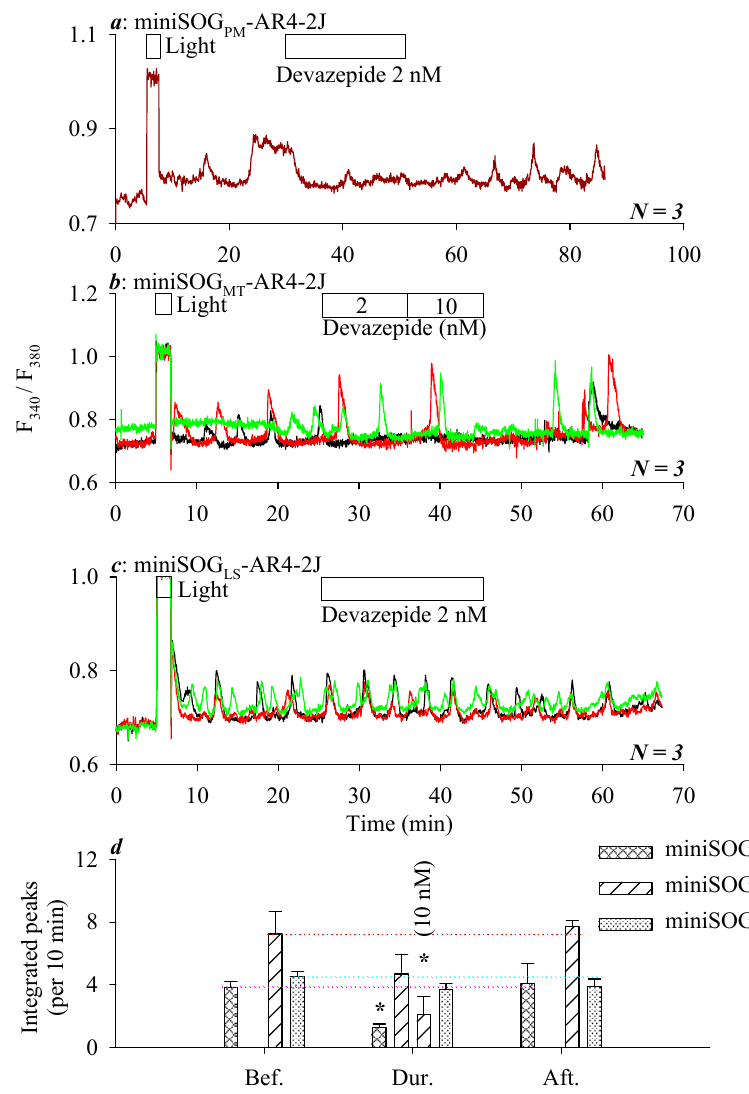
Figure 4. Calcium oscillations induced by miniSOG photodynamic action at the plasma membrane (PM), mitochondria (MT), or lysosomes (LS) in AR4-2J cells showed graded sensitivity to inhibition by the CCK1R antagonist devazepide at 2 nM: PM > MT > LS. Fura-2 AM-loaded miniSOG PM -AR4-2J ( a ), miniSOG MT -AR4-2J ( b ), or miniSOG LS -AR4-2J cells ( c ) were perfused; devazepide (2, 10 nM) and LED light (450 nm, 85 mW·cm − 2 , 1.5 min) were applied as indicated by the horizontal bars. The calcium tracings are each from individual cells measured simultaneously in one out of N (as indicated) identical experiments, the ordinate being fluorescence ratios in F 340 / F 380 and the abscissa being time in min, as indicated. Integrated calcium peaks (per 10 min) from N experiments were plotted, and statistically significant differences between before (Bef.) and during (Dur.) or after (Aft.) devazepide application were indicated by an asterisk (*) at p < 0.05 ( d ), for the devazepide inhibition of miniSOG photodynamically induced calcium oscillations with miniSOG PM or miniSOG LS . Note the thin pink (PM), cyan (MT), and red (LS) dotted horizontal lines (3) at the level before the devazepide application in miniSOG PM -AR4-2J, miniSOG MT -AR4-2J, and miniSOG LS -AR4-2J cells, respectively ( d ). In miniSOG MT -AR4-2J cells before devazepide 2 nM, the calcium response was 100%, during devazepide 2 nM, 65%, during devazepide 10 nM, 29%, and after devazepide, 106%. For better consistence, for miniSOG MT -AR4-2J cells, the statistical data in ( d ) were from all individual cells in one out of three identical experiments shown in ( b ).